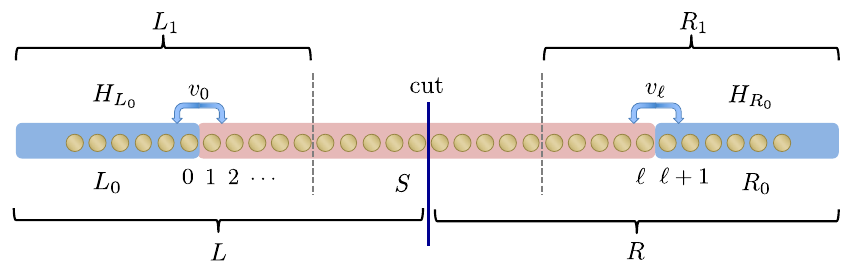
FIG. 5. The decomposition of the system considered in the